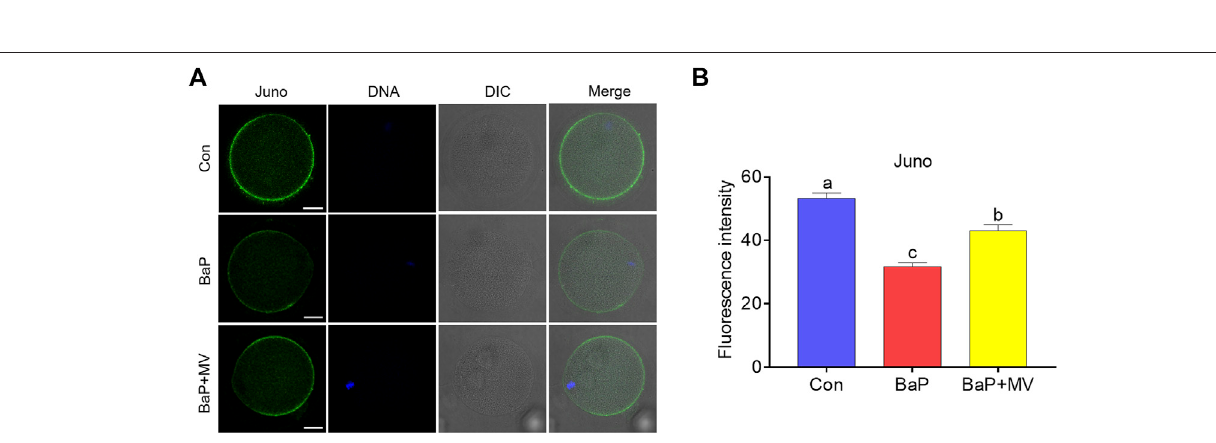
Frontiers in Pharmacology |